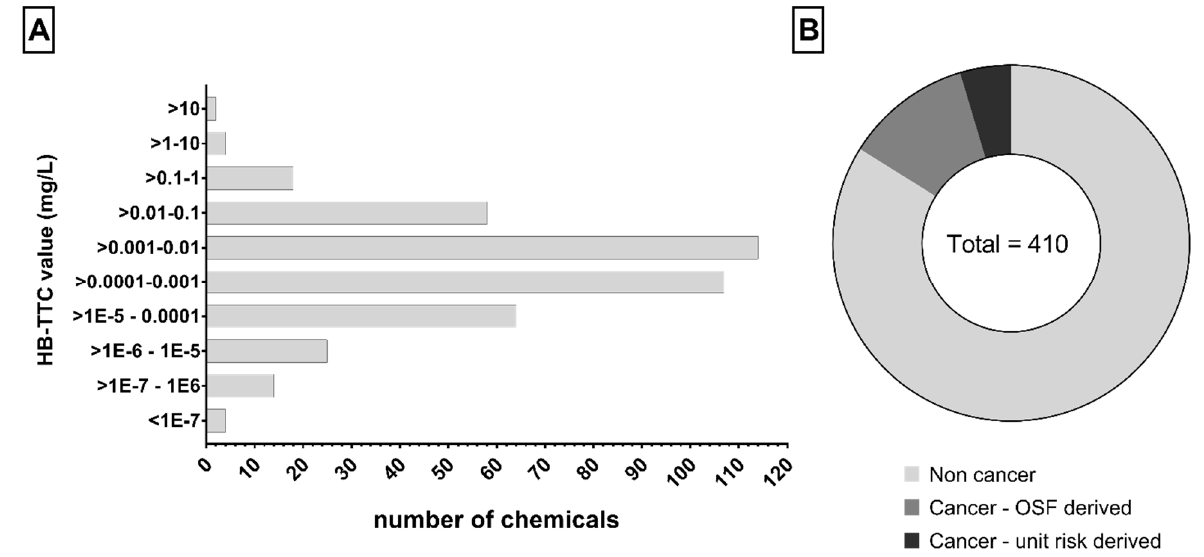
Figure 2. Compound-specific HB-TTCs for 410 chemicals: ( A ) distribution of values, ( B ) toxicological features. OSF = Oral Slope Factor.